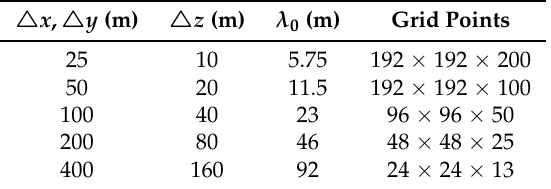
Table 2. A summary of the specifications for the convective boundary layer simulations (CBL2) with